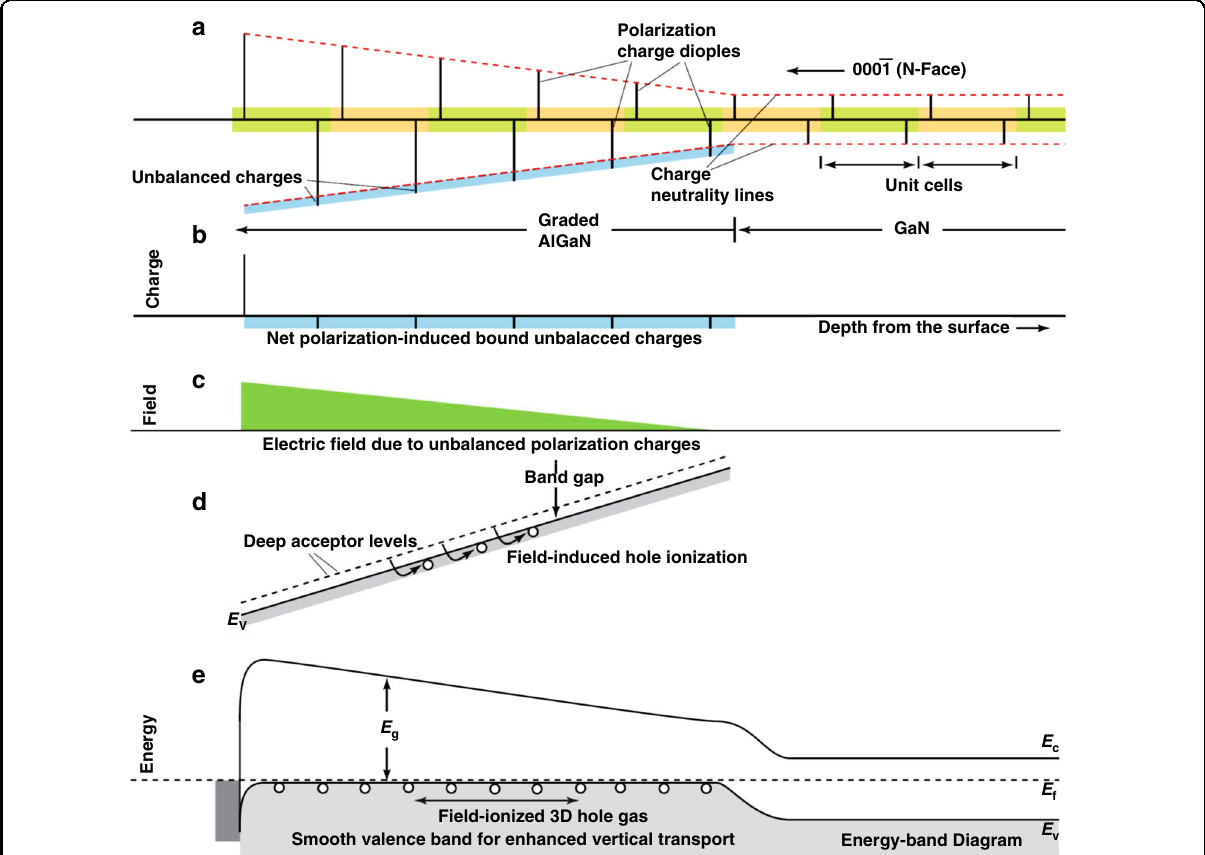
Fig. 13 Schematic illustration of polarization-induced p -type doping in graded polar heterostructures. a Sheets of charge dipoles in every unit cell of the crystal. The net unbalanced polarization charge is shown in ( b ), which leads to the electric fi eld in ( c ), and the energyband bending in the valence band in ( d ) if holes are not ionized. Field ionization of holes results in a steady-state energy-band diagram shown in ( e ), which highlights the smooth valence-band edge without any potential barriers for hole fl ow. E f , is the Fermi level; E c and E v are the conduction and valence-band edges, respectively; and E g is the band gap. Figures reproduced from ref. 157 , © 2010